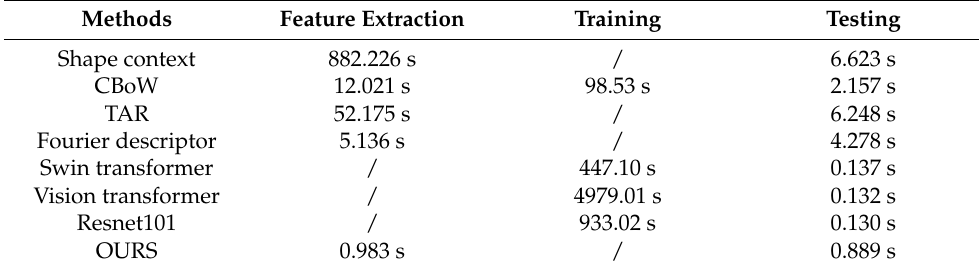
Figure 18. Computational complexity requirements vs. classification performance. ( a ) Accuracy versus param size; ( b ) precision versus param size; ( c ) recall versus param size; and ( d ) F1-score versus param size. Table 9. Time consumption with different classification